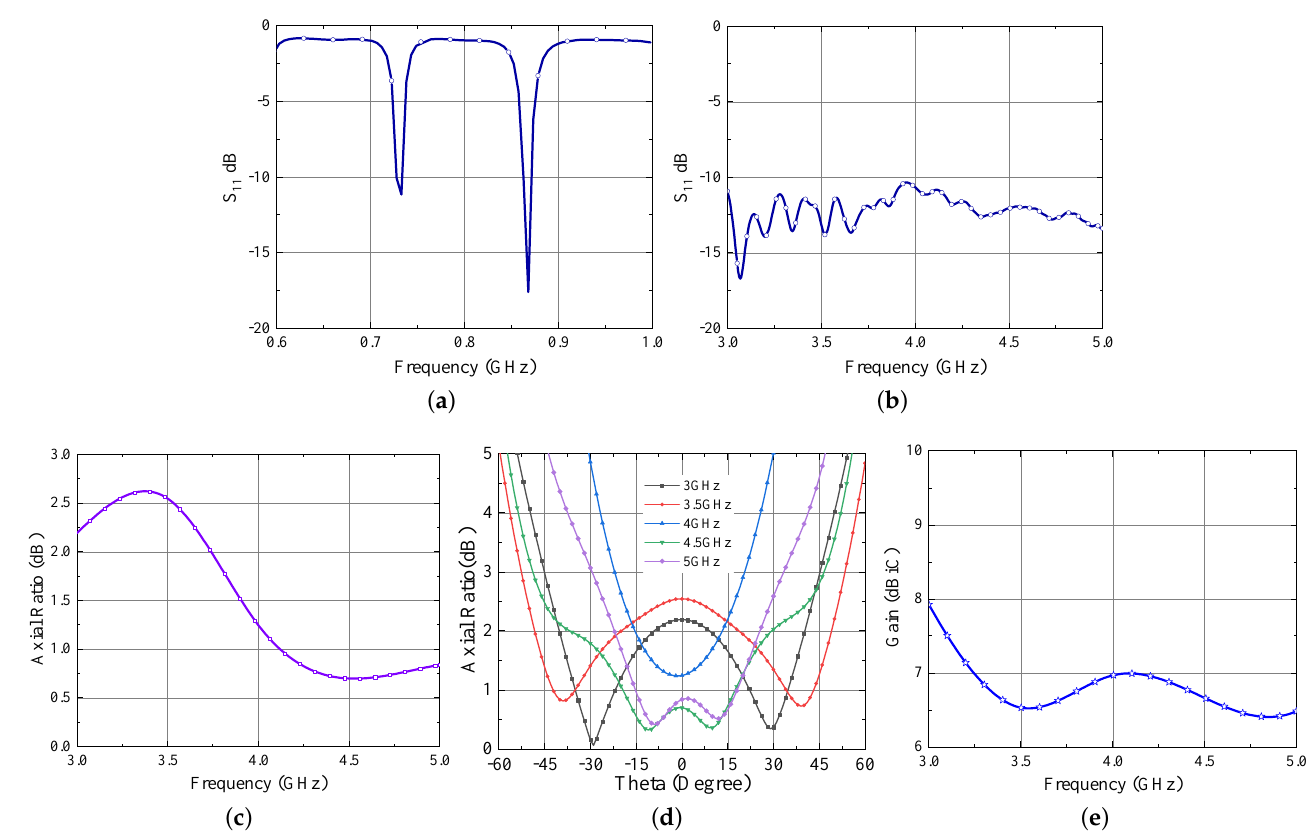
Figure 13. Simulated responses of hybrid UWB antenna ( a ) S 11 for UHF band (normalized to 12 Ω ) ( b ) S 11 for UWB band (normalized to 120 Ω ) ( c ) Axial Ratio v/s Freq ( d ) Axial Ratio v/s Theta ( e )